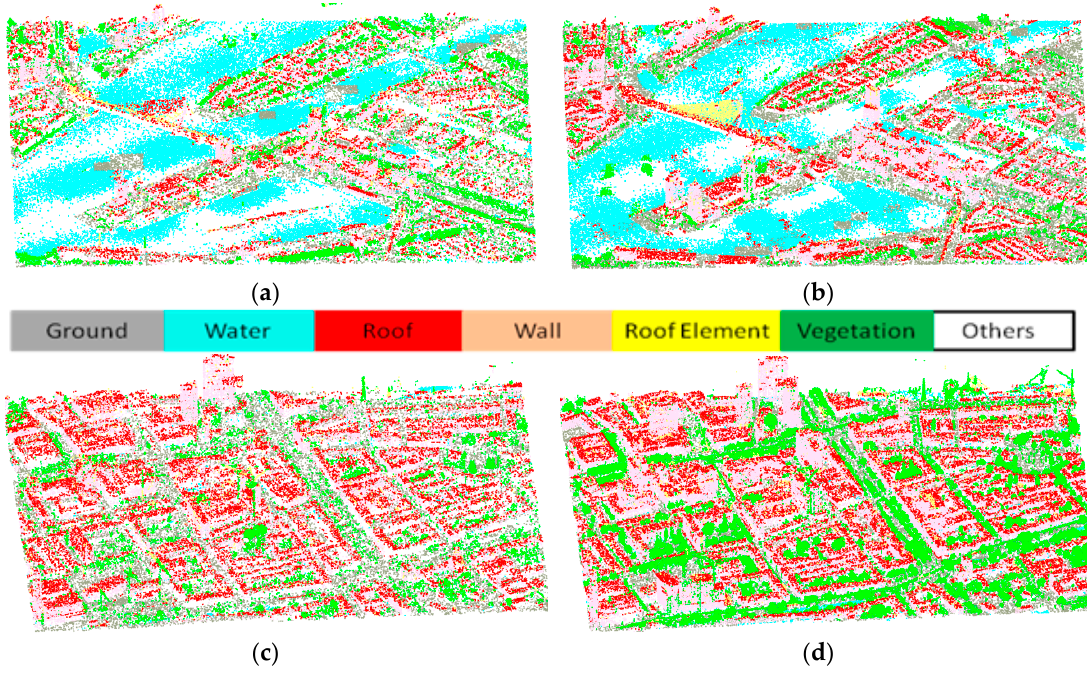
Figure 11. The scene classification results for the test areas. ( a ) 2008—commercial area; ( b ) 2010—commercial area; ( c ) 2010—residential area; ( d ) 2012—residential area.